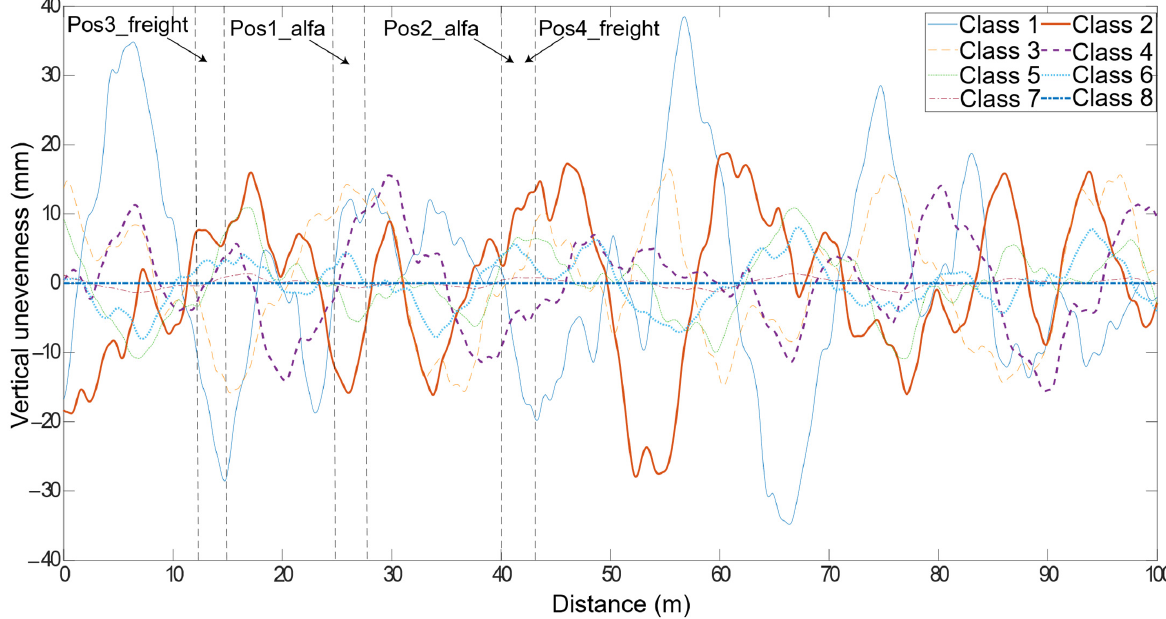
Figure 4. Unevenness profiles of the rail, including different classes proposed by FRA.